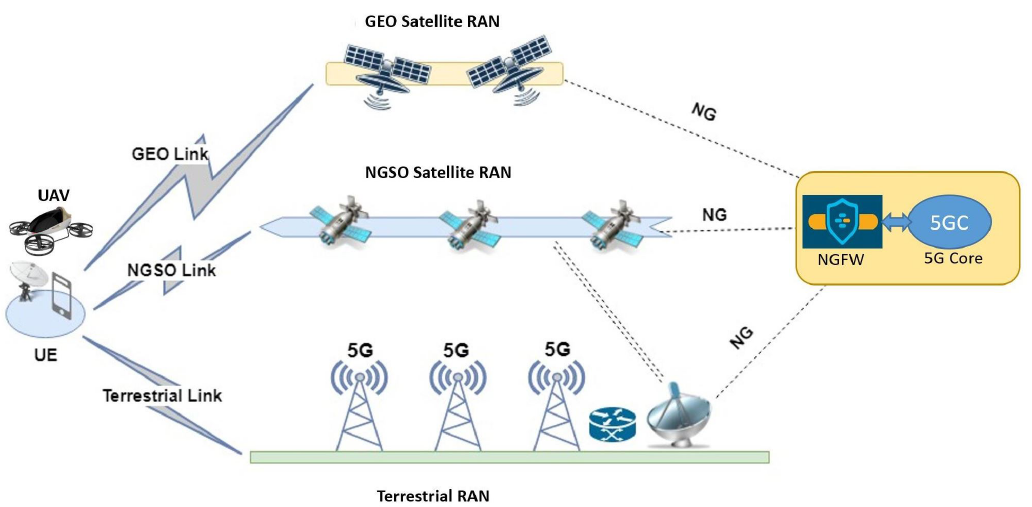
Figure 4. Multi-connectivity architecture with terrestrial, NGSO satellite, and GEO satellite